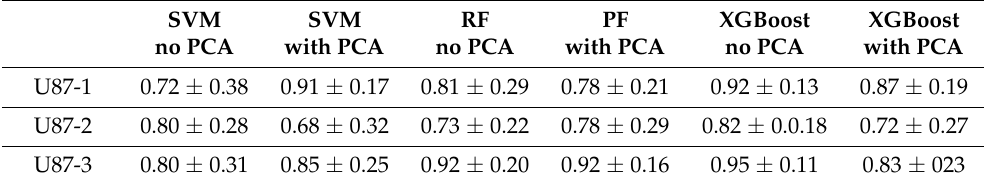
Table 2. Mean and standard deviation of AUC for SVM, RF,